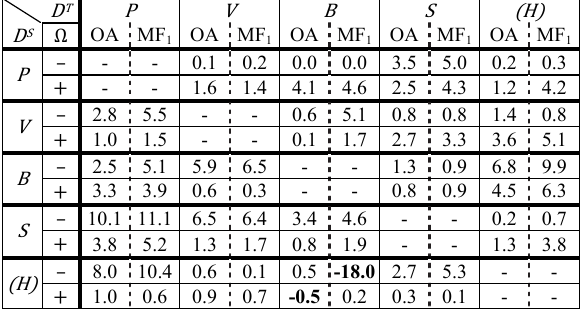
trees. This is clearly visible in the exemplary patch for H , captured in autumn, showing several trees without leaves. The images for the domains (cid:4670)V, B, S (cid:4671) were captured in summer, thus, do not contain any trees without leaves. Even after adaptation, the models barely detect any of the trees in H , while they are detected when coming from D S (cid:3404) P , the only other domain captured in